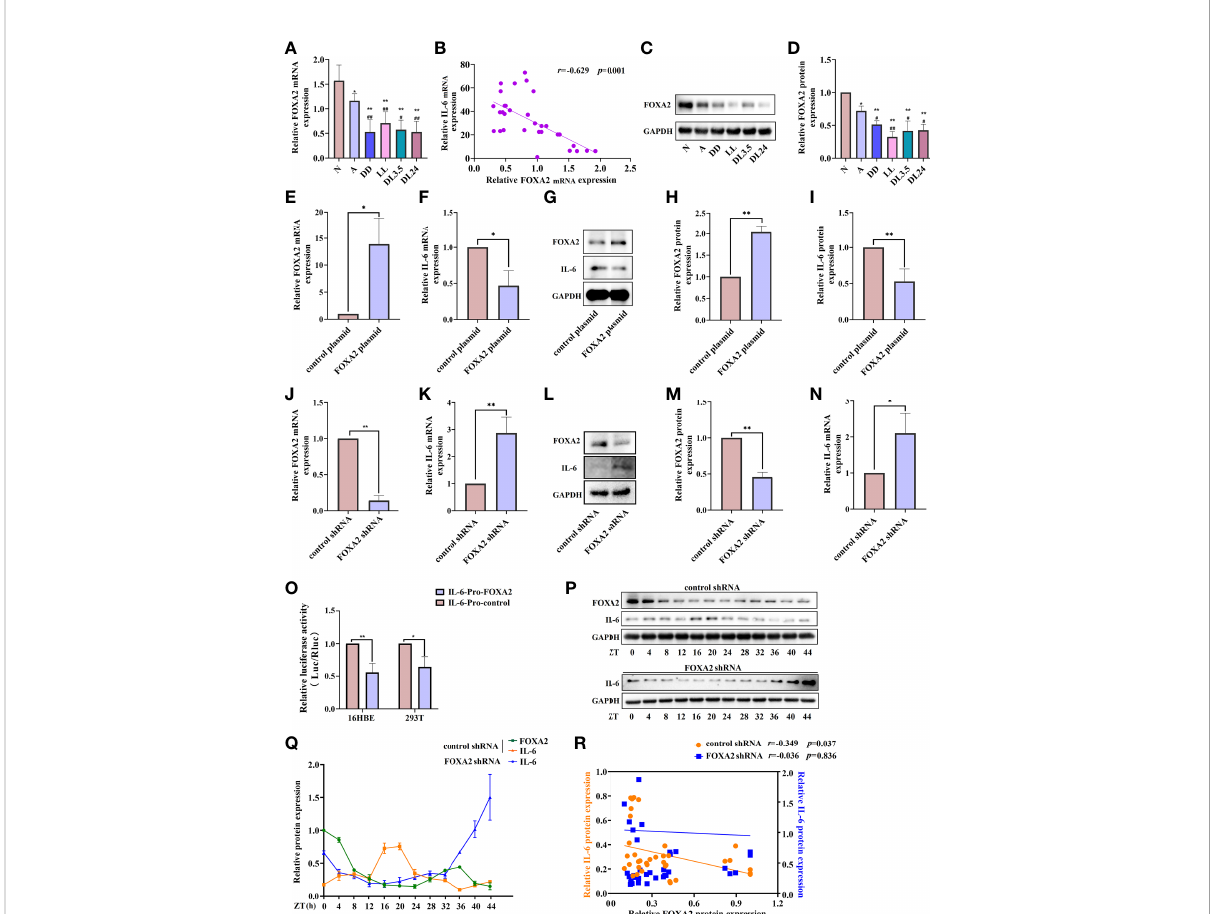
FIGURE 6 FOXA2 regulates the expression and rhythm fl uctuations of IL-6. (A) RT-qPCR analysis of the mRNA levels of FOXA2 in lung tissue. (B) Correlational analyses between FOXA2 and IL-6 mRNA expression levels in lung tissue. (C) Western blot analysis of the protein levels of FOXA2 in mouse lung tissue of each group. ImageJ software was used to quantify FOXA2 (D) . RT-qPCR analysis of the mRNA levels of FOXA2 (E) and IL-6 (F) after the transfection of 16HBE cells with a FOXA2 over-expression (FOXA2 plasmid) and control plasmid. Western blot analysis of the protein levels of FOXA2 and IL-6 in 16HBE cells transfected with the FOXA2 and control plasmids (G) . ImageJ software was used to quantify FOXA2 (H) and IL-6 (I) bands. RT-qPCR analysis of the mRNA levels of FOXA2 (J) and IL-6 (K) expression in 16HBE cells with FOXA2 shRNA and control shRNA. Western blot analysis of the protein levels of FOXA2 and IL-6 in 16HBE cells transfected with FOXA2 shRNA and control shRNA (L) , ImageJ software was used to quantify FOXA2 (M) and IL-6 (N) bands. (O) Luciferase reporter assay analysis of the luciferase expression in the 16HBE and 293T cells transient transfection of FOXA2 and empty vector. Western blot analysis of the protein levels of FOXA2 and IL-6 in control shRNA and FOXA2 shRNA cells in response to serum shock synchronisation (P) , IL-6 and FOXA2 bands were quantitatively analysed by ImageJ software (Q) . (R) Correlational analyses between FOXA2 and IL-6 protein expression levels in control shRNA and FOXA2 shRNA cells. The left ordinate and the right ordinate represent the relative protein expression of IL-6 in control shRNA cells and FOXA2 shRNA cells, respectively. N=control group; A=OVA group; DD=OVA + all-day darkness group; LL= OVA + all-daylight; DL3.5= OVA + 3.5 h dark/3.5 h light group; DL24= OVA + 24 h dark/24 h light group. Data of animal experiment are presented as the mean ± SEM of 6 mice per group. Data of cell experiment shown are representative data of one out of at least 3 independent experiments. * p < 0.05, ** p < 0.01, compared with the control group, control plasmid or control shRNA cells. # p < 0.05, ## p < 0.01 compared with the OVA group. One-way ANOVA with Tukey ’ s multiple comparison analysis method, and independent samples t-tests, Pearson ’ s correlation coef fi